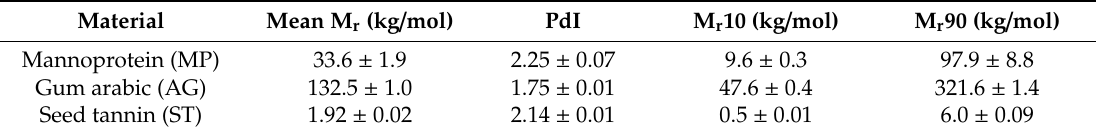
Table 1. Mean and range of molecular weight (M r ) and polydispersity index (PdI) determined by size exclusion